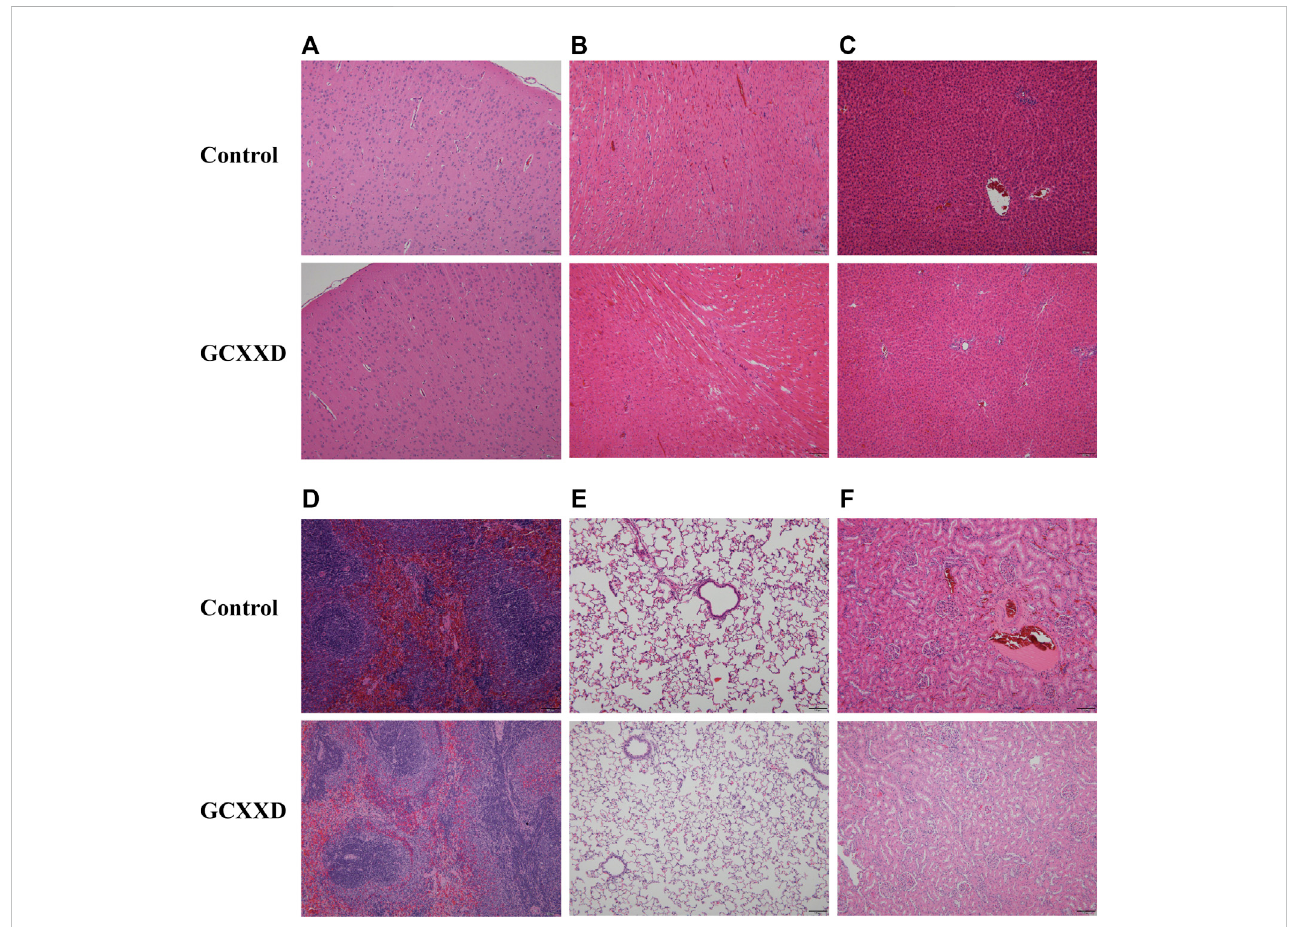
Representative histopathological microphotographs of the brain (A) , heart (B) , liver (C) , spleen (D) , lung (E) , and kidney (F) of rats in the control and GCXXD high-dose groups at the end of administration. Scale bar: 100 μ